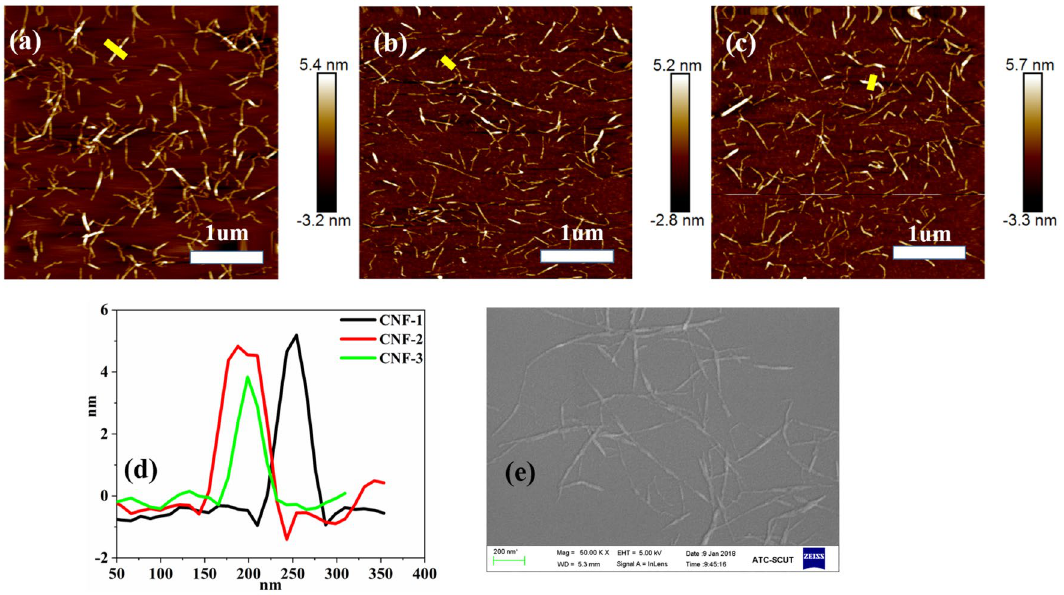
Figure 1. AFM topography images showing height measurements of ( a ) CNF-1, ( b ) CNF-2, ( c ) CNF-3. ( d ) AFM line scan of CNFs image. The height data corresponds to the yellow bar in the AFM images. ( e ) SEM image of